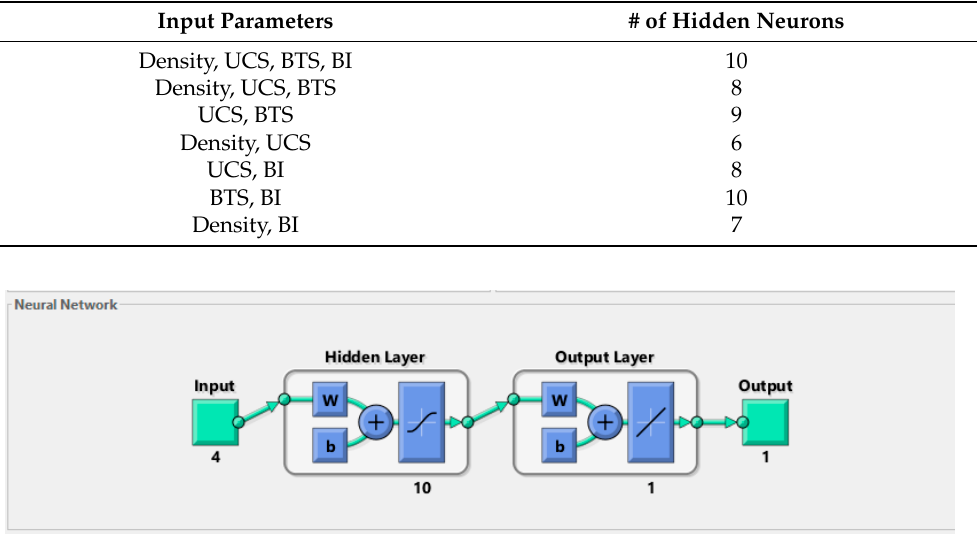
Figure 14. Generalized structure of ANN used in this study.